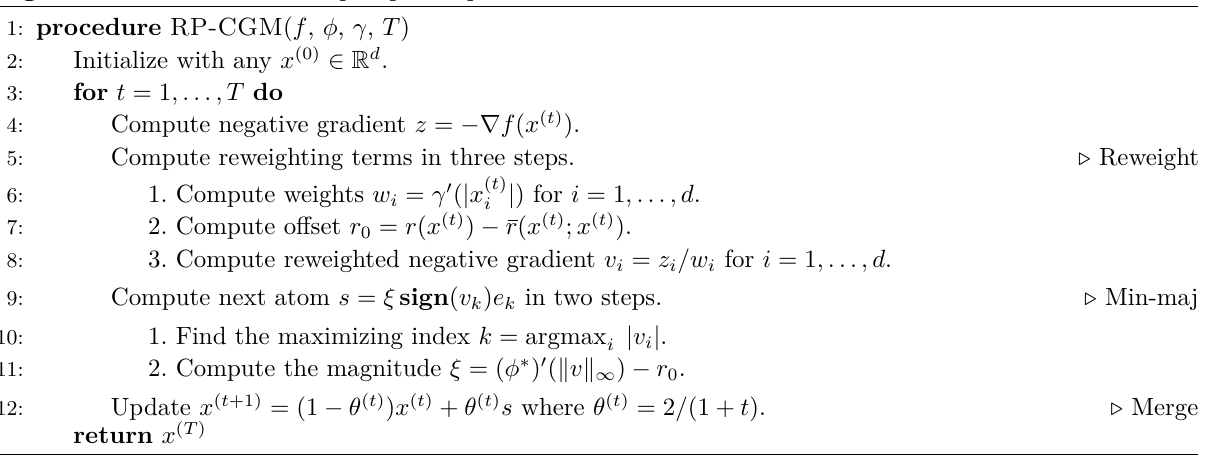
Algorithm 1 RP-CGM on simple sparse